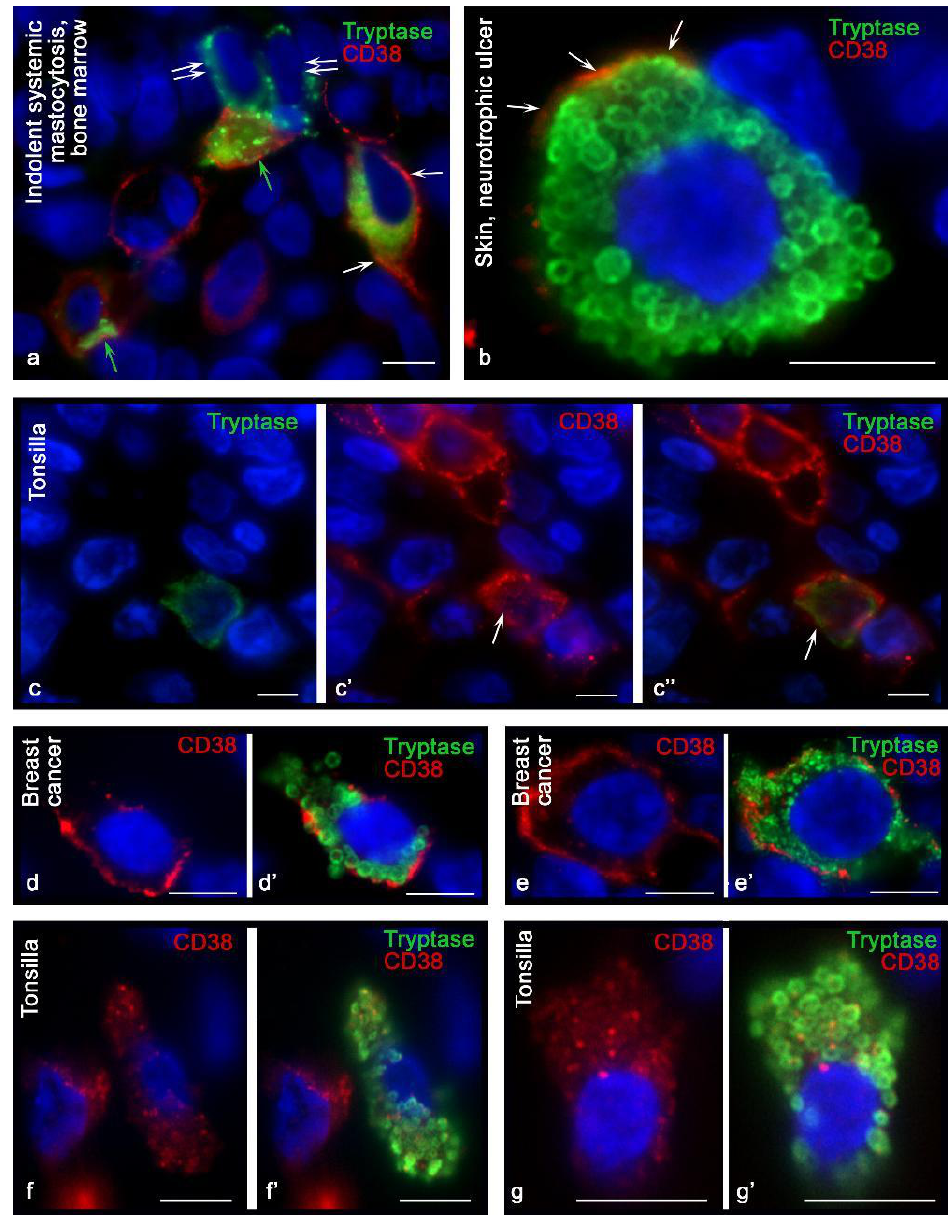
Figure 2. Intracellular distribution of CD38 in mast cells. Primary antibodies used: ( a , b , d , e ) mouse monoclonal (kindly provided by Fabio Malavasi, University of Torino, Italy); ( c , f , g ) rabbit monoclonal (Cell Marque, USA). ( a ) Indolent systemic mastocytosis, bone marrow. In the type-1a hypochromic mast cell, the predominant localization of CD38 on the plasma membrane is revealed (indicated by the arrow). MCs with CD38 localization on intracellular structures (green arrow) and lack of exoenzyme expression (double arrow) are found. ( b ) Skin, neurotrophic ulcer. Expression of CD38 on the mast cell plasmalemma is unequal, with the highest expression at some loci (indicated by an arrow). ( c – c″ ) Extrafollicular lymphoid tissue of the tonsil. In the mast cell, predominantly intracytoplasmic expression of CD38 is detected (indicated by the arrow). ( d , d’ , e , e′ ) Breast cancer. Variants of CD38 distribution on mast cell plasmalemma. ( f , f′ , g , g′ ) Tonsilla. Stroma. Predominantly intracytoplasmic expression of CD38. Scale bar: 5 µm.